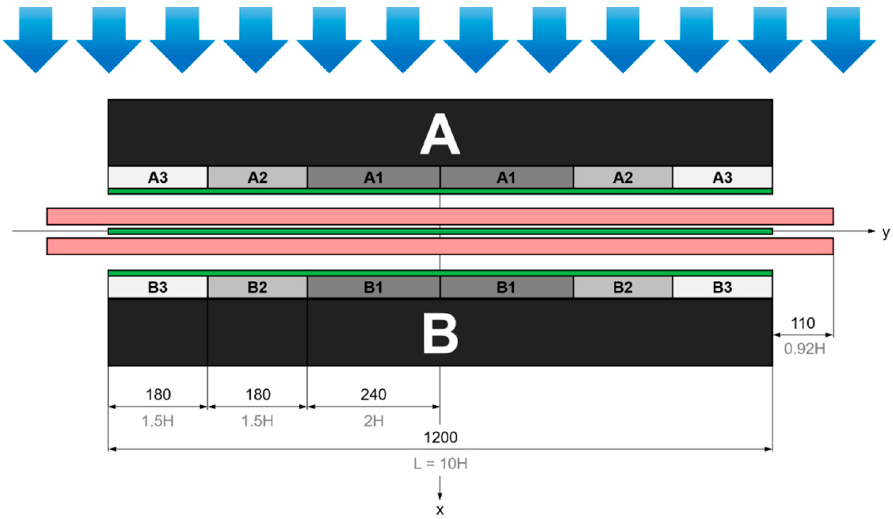
Figure 3. Top view of the street canyon. Location of the pre-defined concentration measurement areas (A1–A3 and B1–B3).